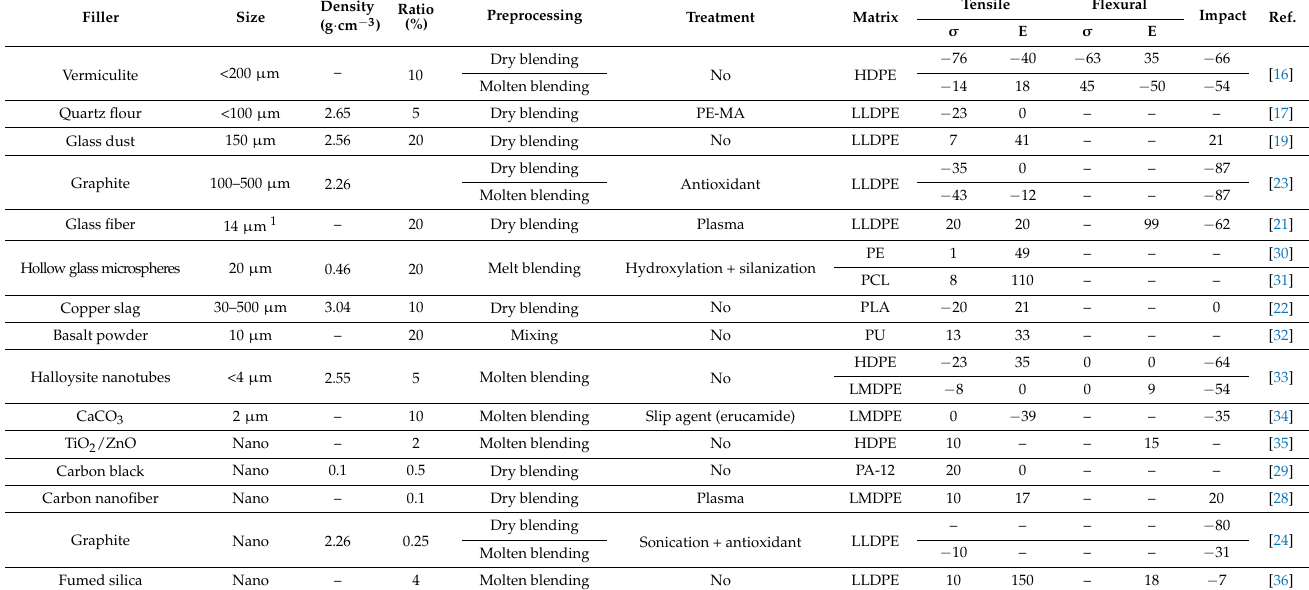
Table 2. Summary of results obtained from the literature for composites with inorganic fillers and reinforcements and several polymer composites ( σ : strength, E: elastic modulus, both given as variation regarding the neat polymer matrix and given in